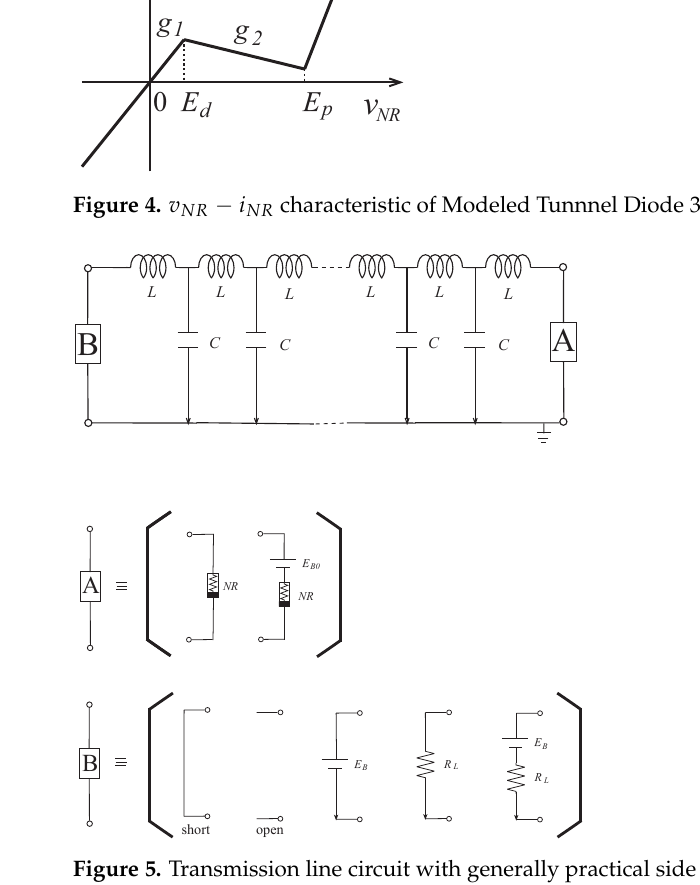
Figure 5. Transmission line circuit with generally practical side terminal conditions.